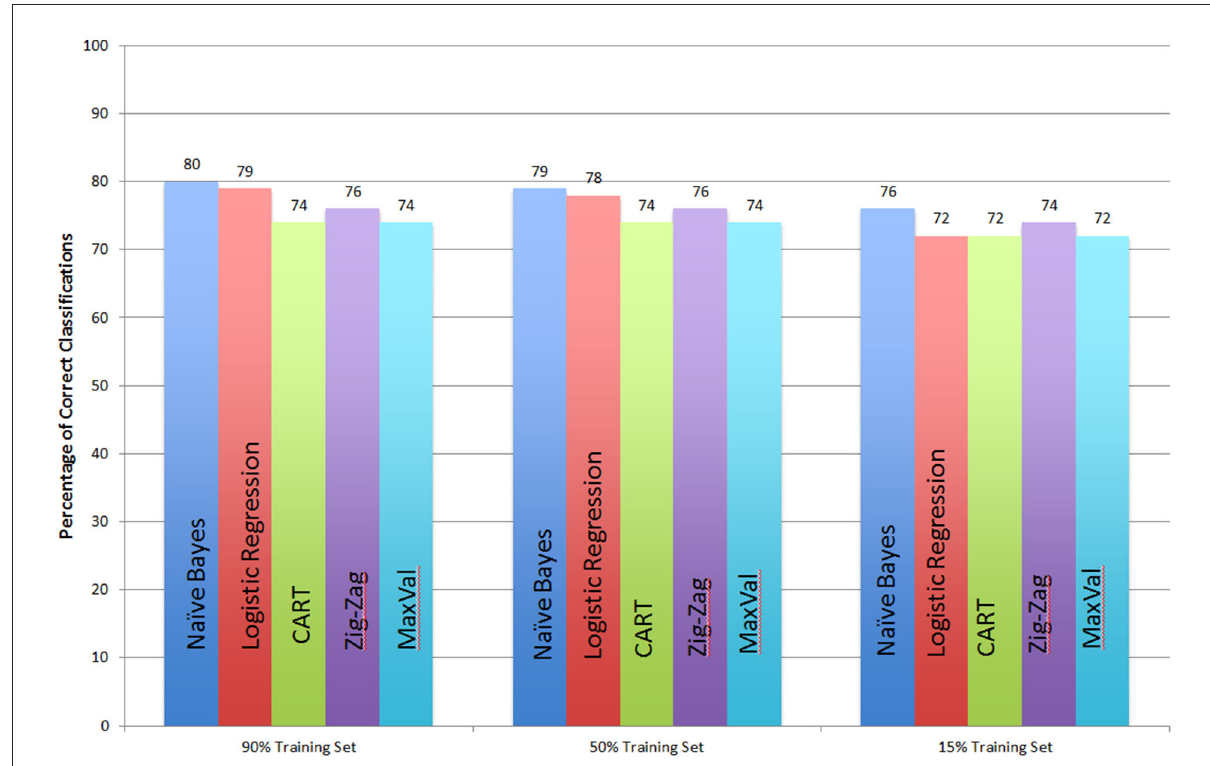
FIGURE15 Comparison of 5 classifiers: Naïve Bayes, Logistic Regression, CART, Fast and Frugal tree with a Zig-Zag rule, and with a Max-Val